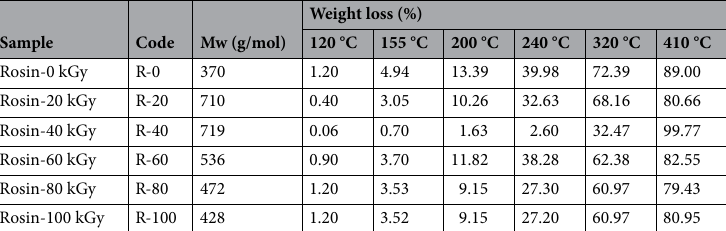
Table 1. Molecular weights by GPC and weight loss (%) by TGA of R-0, R-20, R-40, R-60, R-80, and R-100 samples.